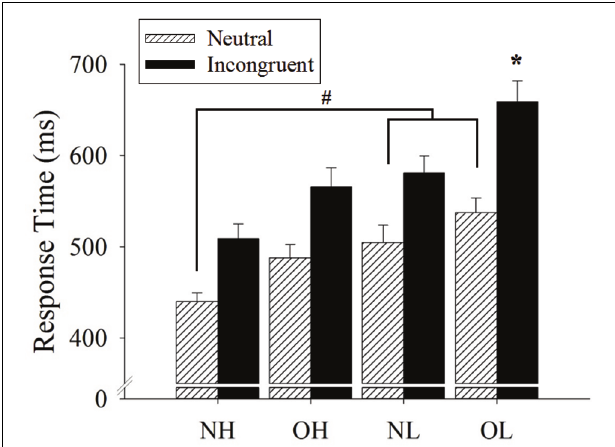
FIGURE 1 | Response time (mean ± SE) of Stroop neutral and incongruent conditions across four groups: normal-weight and high-fit (NH), obese-weight and high-fit (OH), normal-weight and low-fit (NL), and obese-weight and low-fit (OL). Note that there is a main effect of the Stroop condition, with a shorter response time for the neutral condition as compared to the incongruent condition. # Represents the significant difference in neutral condition. ∗ Represents the significant difference in incongruent